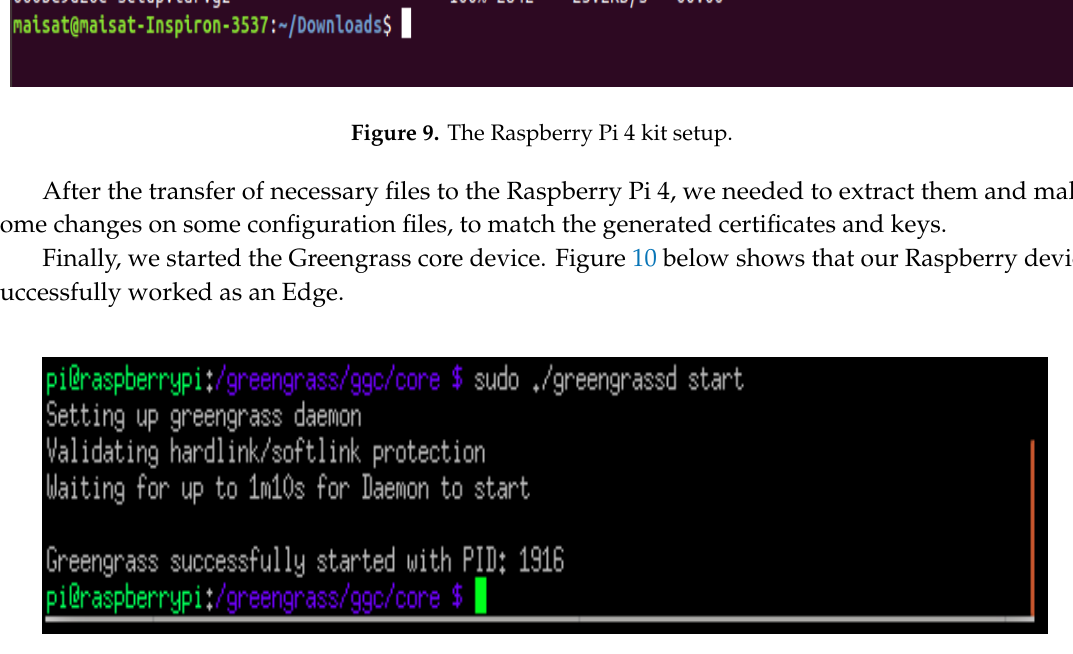
Figure 10. Running Greengrass successfully on the Raspberry Pi 4 kit.